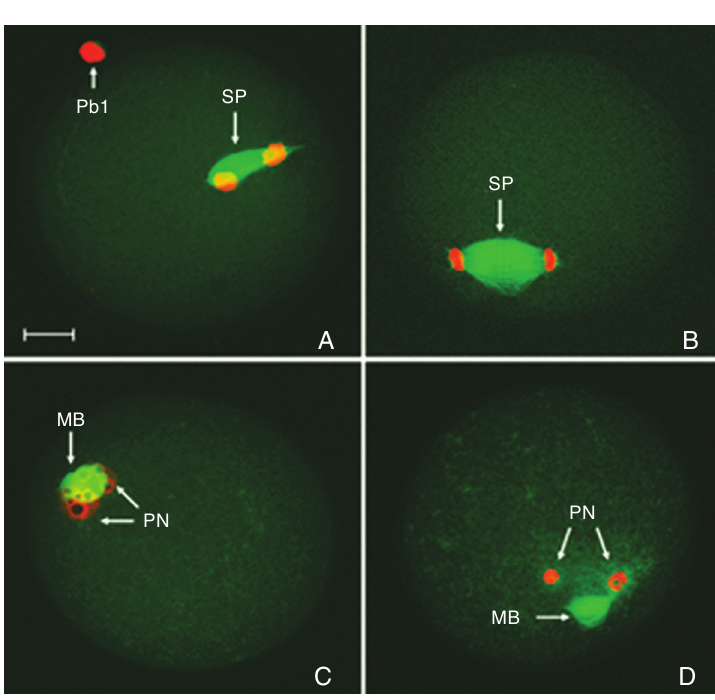
Table 2. Effect of cytochalasin B (CB) treatment on the activation and develop- ment of mouse